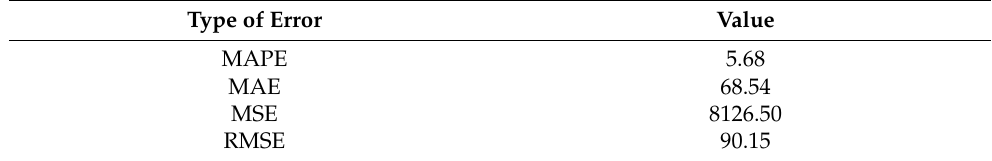
Table 1. Forecasting metrics (experiment